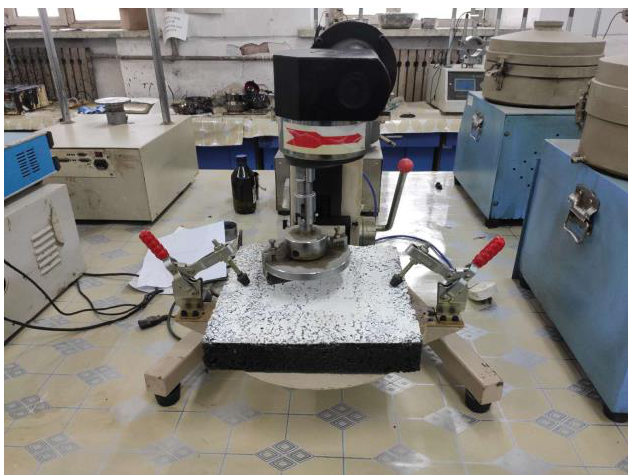
Figure 3. Wet track abrasion test.